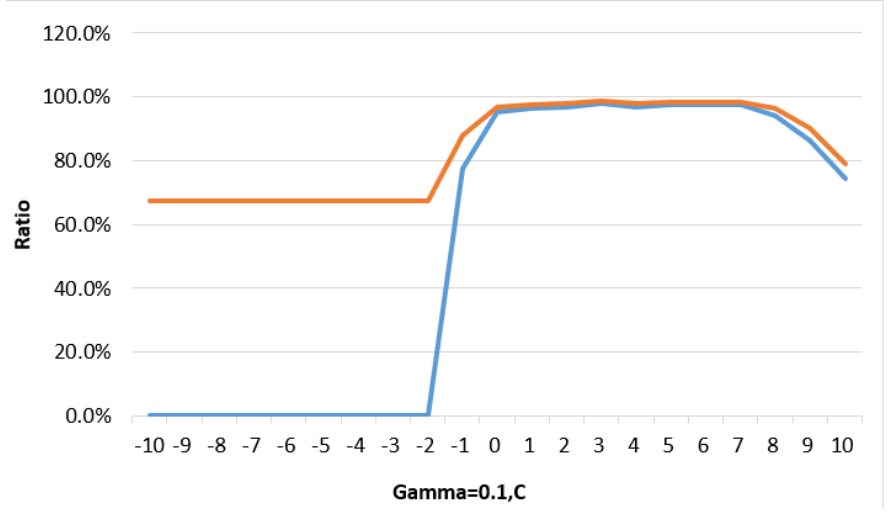
Figure 6. Variation curve of metrics with C at gamma = 0.1. (The red curve represents accuracy while the blue curve represents the F value).